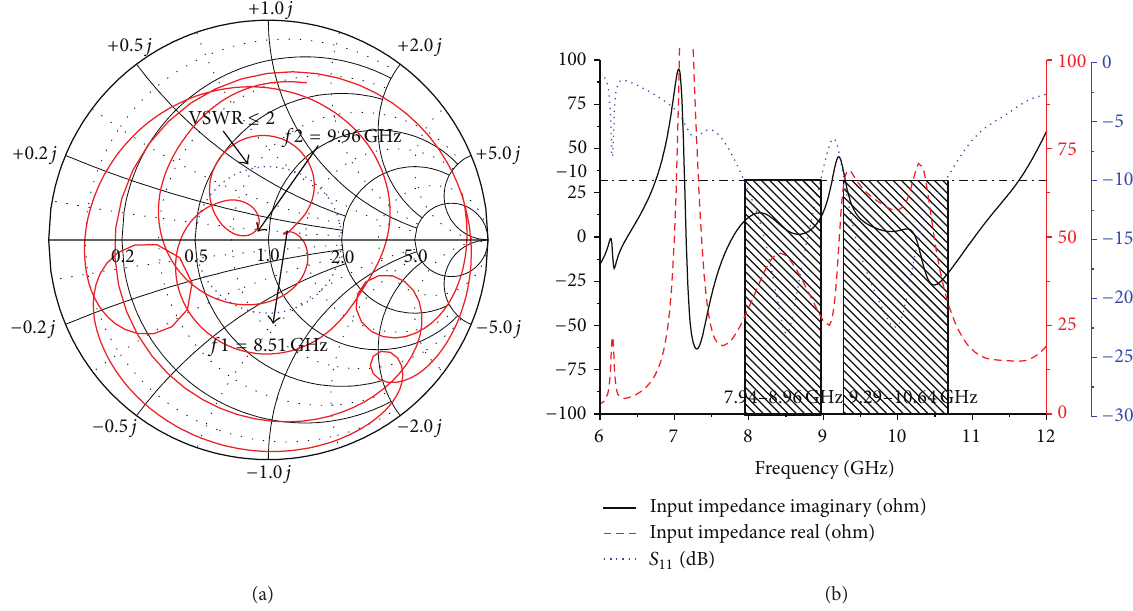
Figure 10: Simulated (a) Smith chart and (b) input impedance for the proposed dual band antenna.